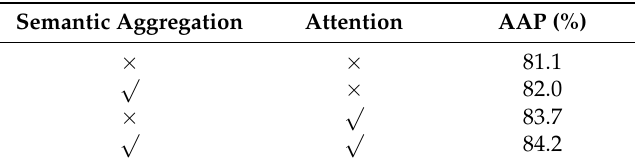
Table 3. Ablation results of the proposed ideas.